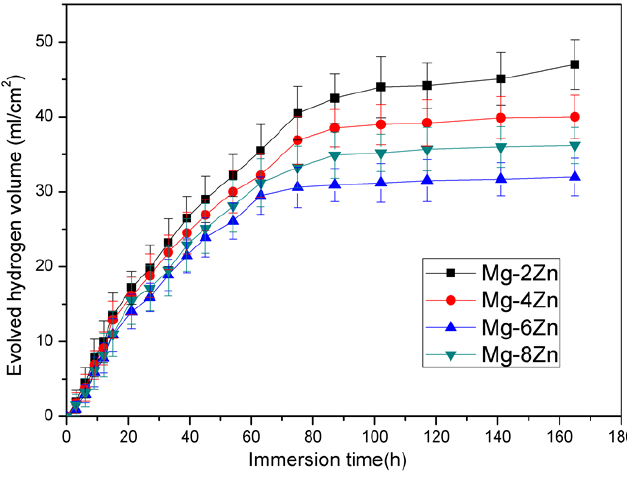
Figure 6. The evolved hydrogen volumes of the Mg-Zn alloys immersed in SBF.